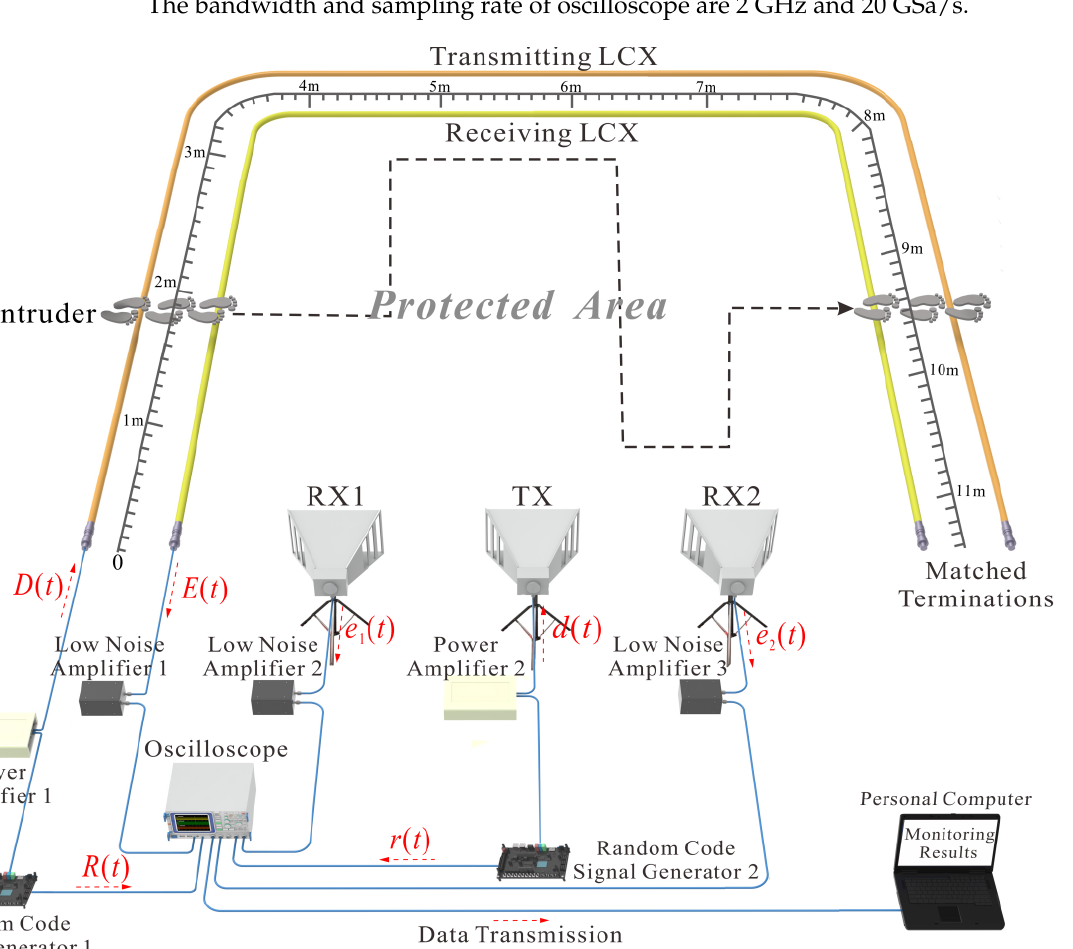
Figure 2. Experimental scene of the intruder entering the protected area. 2.2. Generation and Characteristics of Random Code Signal Figure 3 shows the generation method of the random code signal by sampling and time division multiplexing for output signals from chaotic entropy sources, which is real- ized on an FPGA development board. The chaotic entropy source consists of an autono- mous Boolean network with seven nodes, of which six nodes are exclusive-OR (XOR) log- ical gates and one node is an XNOR (inverse of the XOR) logical gate. Seven nodes form a bidirectional topological ring, and they are connected by adjacent coupling and interval feedback. Firstly, based on the short pulse suppression effect and nonlinear transmission delay characteristics of logical gates in the bidirectional topological ring, the Boolean chaos signal is output from the XNOR logical gate [34]. Secondly, the Boolean chaos signal is sampled through a D flip-flop under the control of a 25 MHz clock, and then the 25